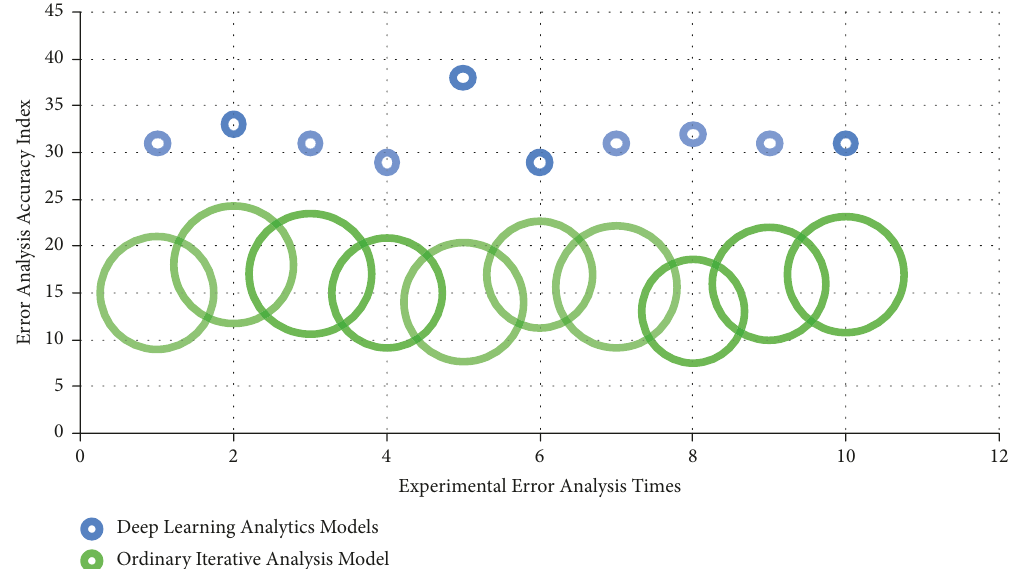
Figure 9: Use the original experimental data to make corrections to the relevant presentation forms within a controllable